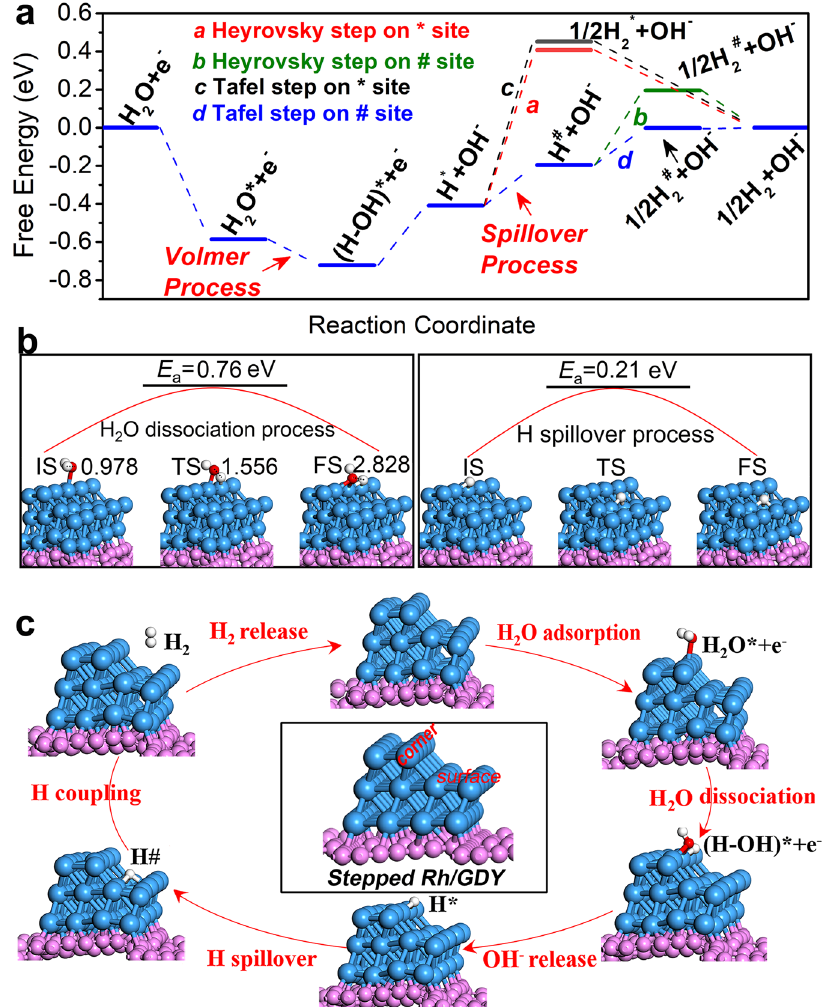
Fig. 5 | Adsorptionenergetictrend and pathwaysonRh/GDY. a Energydiagram of Volmer − Tafel pathway for HER on the Rh/GDY. b TS transition state (TSs) with theNEBbarriersforH 2 OdissociationandHmigration,respectively.Thepink,blue,